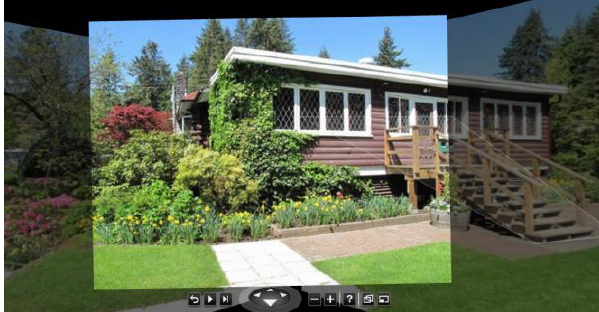
Figure 13 PhotoSynth™ 3D Reconstruction of a Building